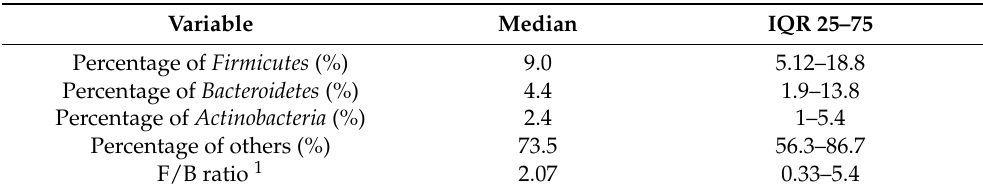
Table 1. Bacterial phyla in human milk samples from women from the metropolitan area of Guadala- jara ( n =